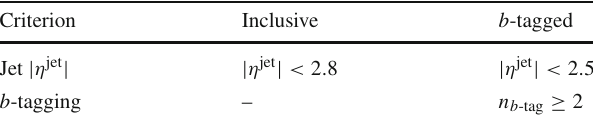
Table 4 Cuts applied to distinguish inclusive and b - tagged signal regions